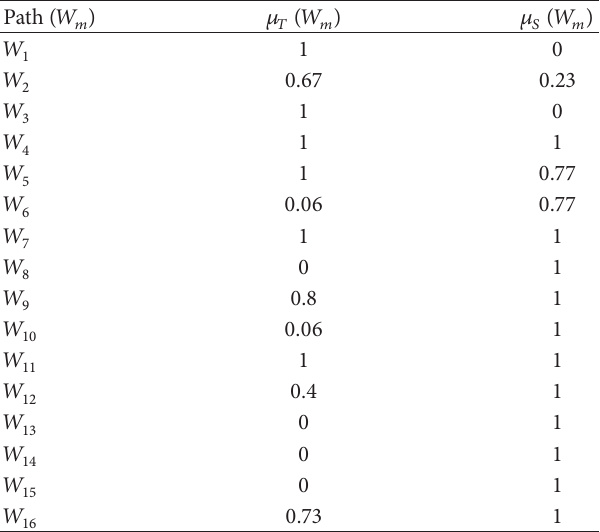
Table 5: The grade of membership of each possible path for the membership functions of both time and